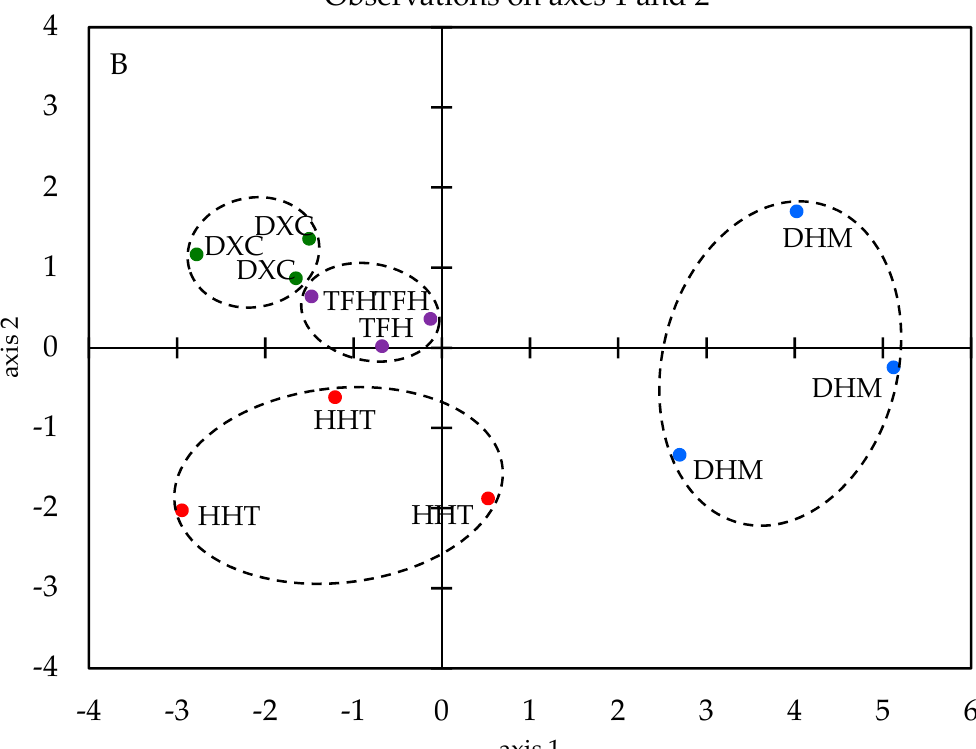
Figure 3. ( A ) Biplot (score plots and load plots) for PCA based on sensor response data. The blue dots represent the samples from marinated pork hocks, and the red dots represent different sensors. ( B ) PLS-DA of E-nose response data for different marinated samples (R 2 X = 0.997, R 2 Y = 0.829, Q 2 = 0.407). The blue dots represent DHM, the red dots represent HHT, the purple dots represent TFH, and the green dots represent DXC.